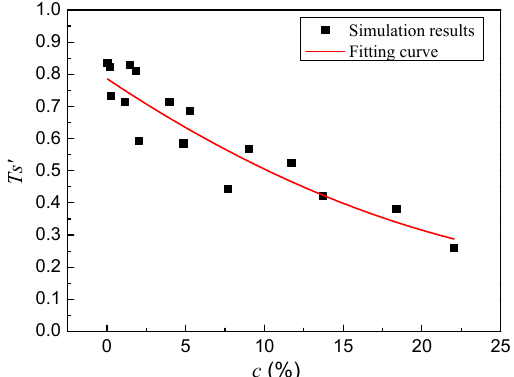
Figure 15. Relationship between Ts ′ and c for all numerical simulation cases.